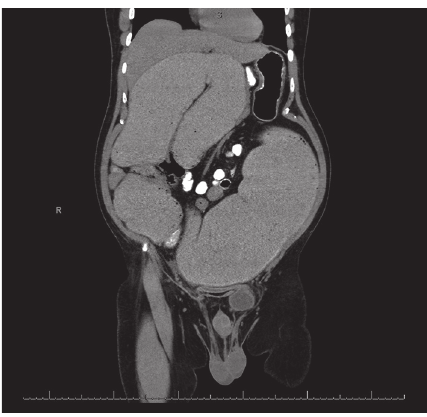
Figure 1: Coronal section of computed tomography without contrast of the abdomen and pelvis demonstrating significant dilation of the colon proximal to the colonic anastomosis from prior sigmoidectomy consistent with an obstructing anastomotic stricture.